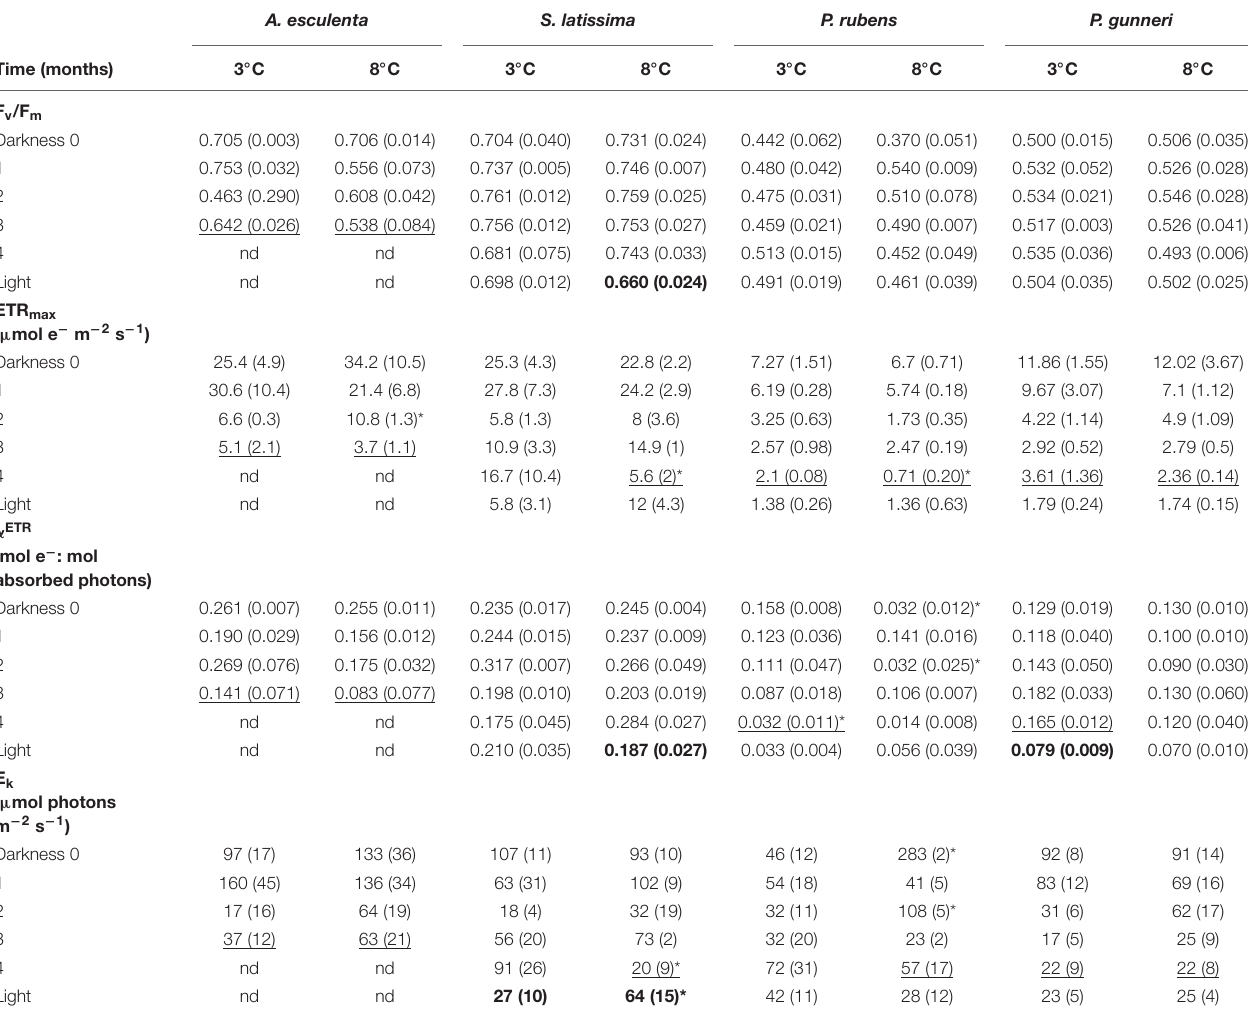
TABLE 1 | Parameters from rapid light curves using PAM fluorometry fitted according to Jassby and Platt (1976) measured during the dark period (Darkness, months) and 7 days after light exposure at increasing photoperiod